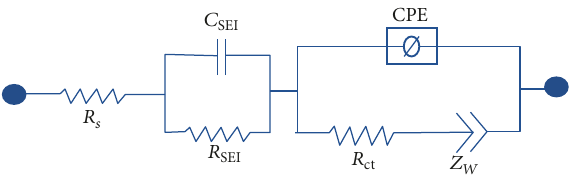
Figure 6: Equivalent circuit model for EIS curves.